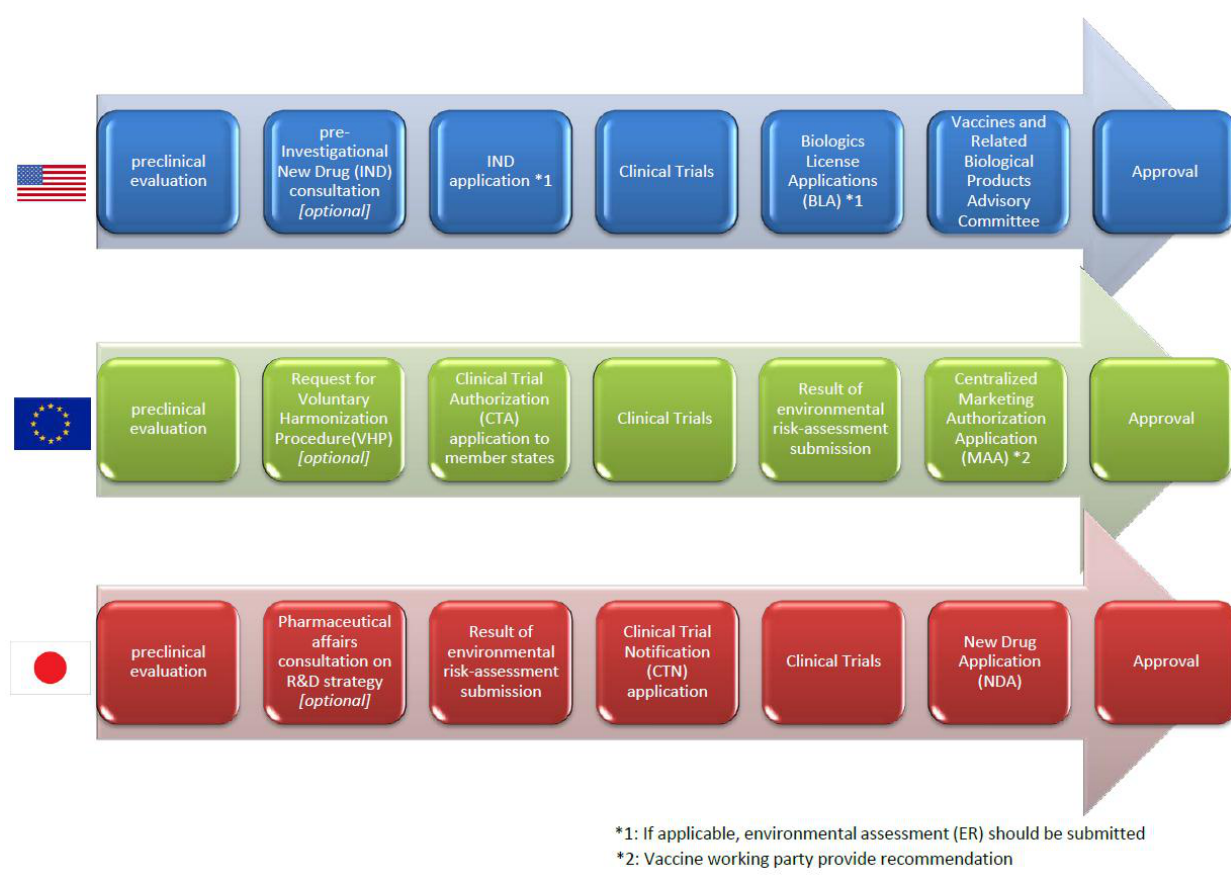
Figure 5. Simplified regulatory pathway from preclinical to the marketing